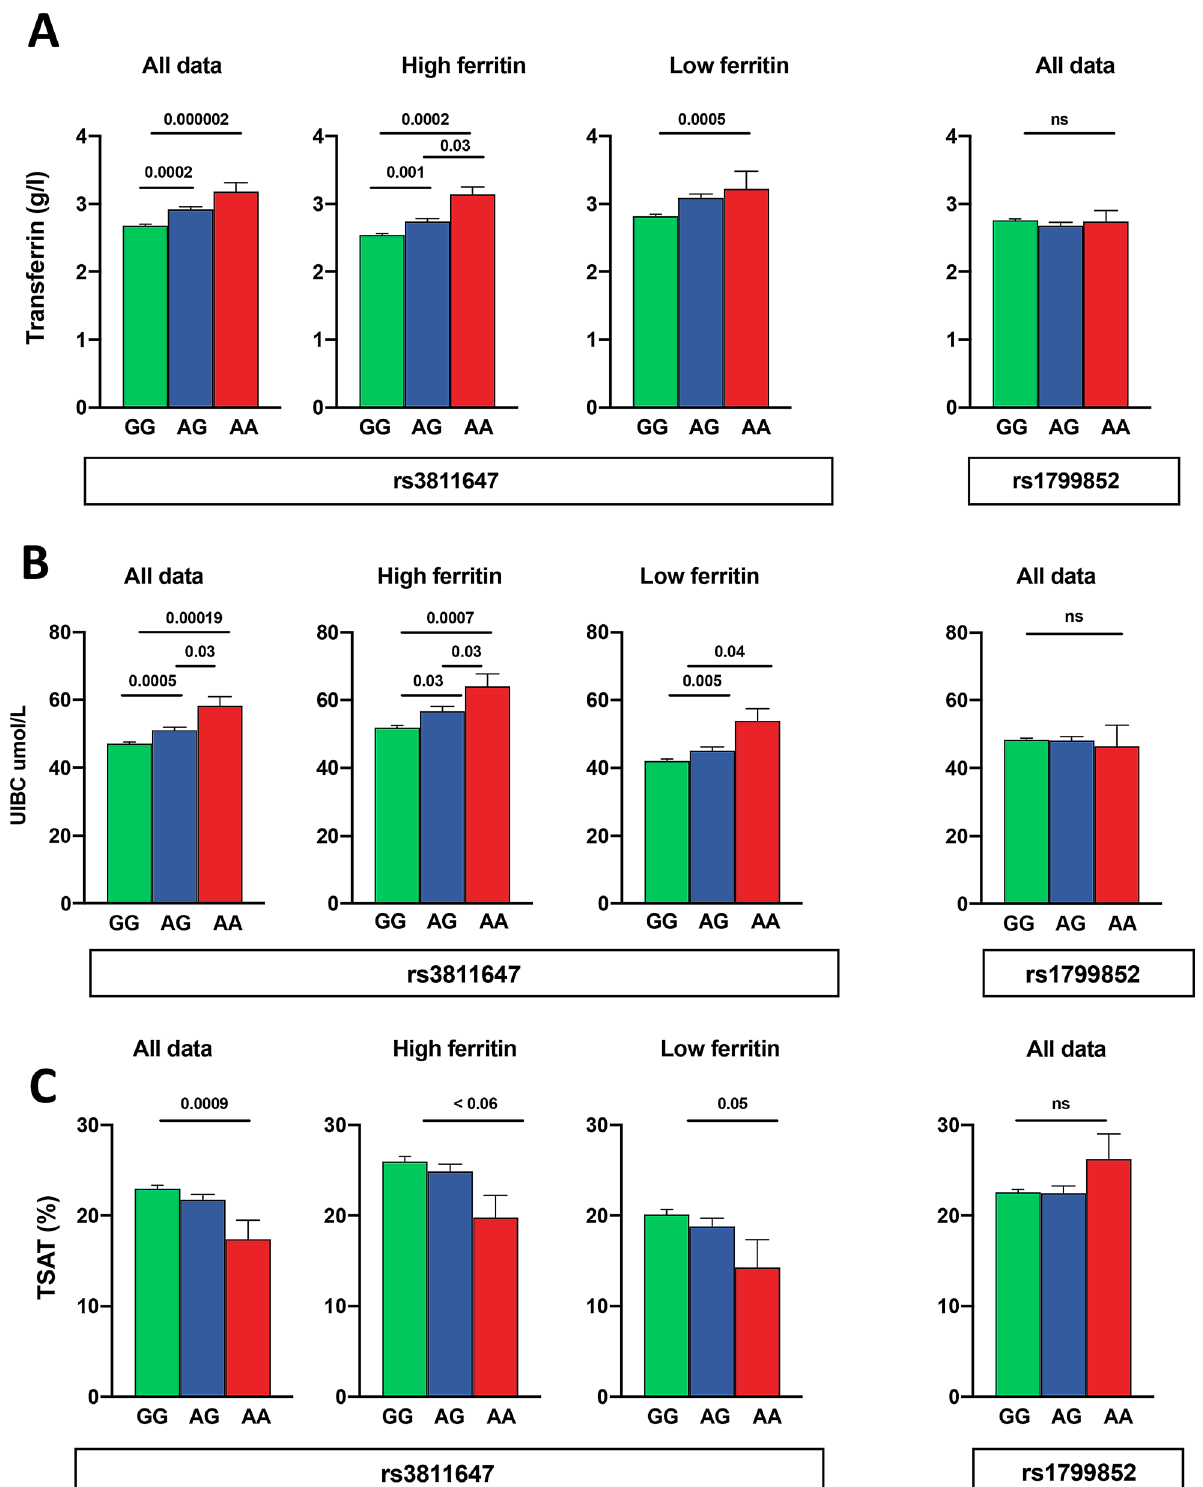
Figure 4. The effects of TF rs3811647 and rs1799852 on plasma iron binding capacity and TSAT. ( A ) Transferrin rs3811647 All data (GG n = 720, GA n = 215, AA n = 24). ANOVA P for trend < 0.0001. Sample divided above and below median ferritin (< 26.9 ng/ml). High ferritin (GG n = 360, GA n = 108, AA n = 15). ANOVA P for trend < 0.0001. Low ferritin (GG n = 360, GA n = 107, AA n = 11). ANOVA P for trend ≤ 0.0001. rs1799852 All data (GG n = 839, GA n = 116, AA n = 4). ANOVA P for trend = NS. ( B ) UIBC rs3811647 All data (GG n = 985, GA n = 301, AA n = 28). ANOVA P for trend < 0.0001. Sample divided above and below median ferritin (< 26 ng/ ml). High ferritin (GG n = 474, GA n = 147, AA n = 16). ANOVA P for trend < 0.0001. Low ferritin (GG n = 511, GA n = 154, AA n = 12). ANOVA P for trend < 0.0001. rs1799852 All data (GG n = 1139, GA n = 116, AA n = 9). ANOVA P for trend = NS. ( C ) TSAT rs3811647 All data (GG n = 720, GA n = 215, AA n = 24). ANOVA P for trend < 0.0001. Sample divided above and below median ferritin (< 26 ng/ ml). High ferritin (GG n = 360, GA n = 108, AA n =